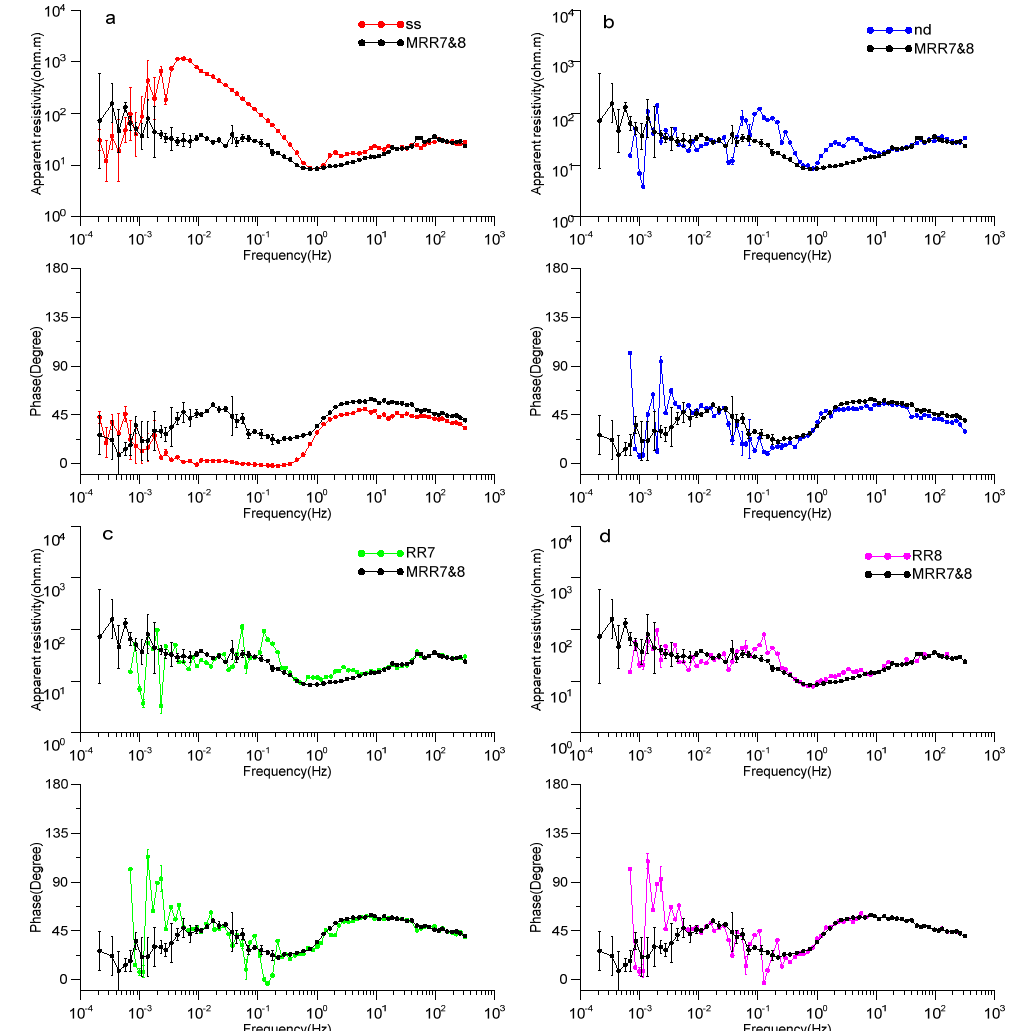
Figure 7. Plots of apparent resistivity and phase data of station 2. Red curves denote the single station (ss), blue curves denote nocturnal data (nd), magenta curves denote station 8 as a remote reference (RR8), green curves denote station 7 as a remote reference (RR7), and black curves denote stations 7 and 8 as remote references (MRR7&8). ( a ) Comparison of ss and MRR. ( b ) Comparison of nd and MRR. ( c ) Comparison of RR7 and MRR. ( d ) Comparison of RR8 and MRR